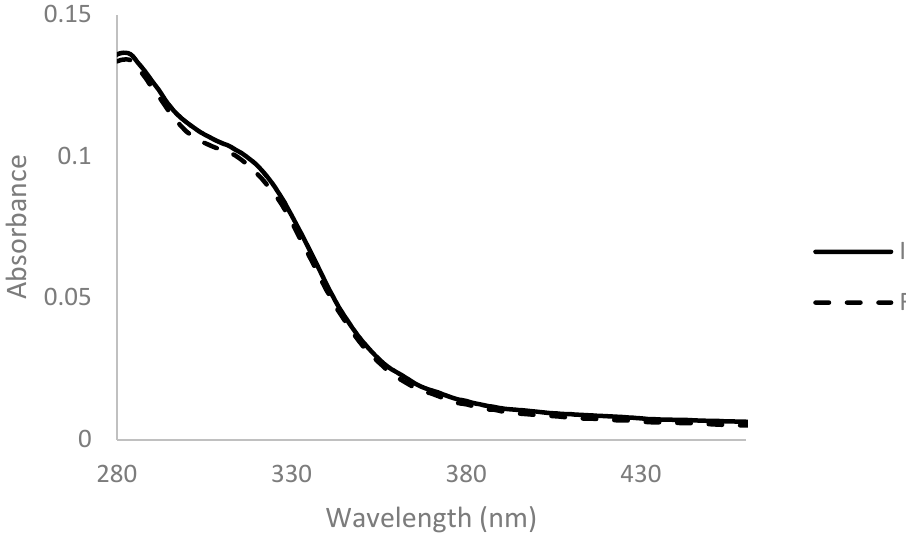
Figure 1. Absorbance spectra of arabinoxylan extract with 0.5% ( w / v ) of activated charcoal before (full line) and after 1 h of contact (dashed line), for a dilution ratio of